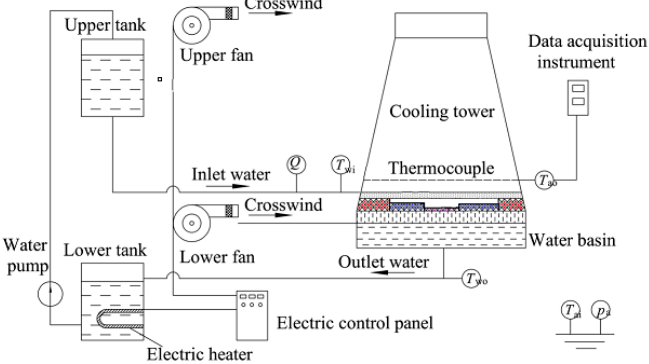
Figure 1. Schematic diagram of the experimental cooling tower.